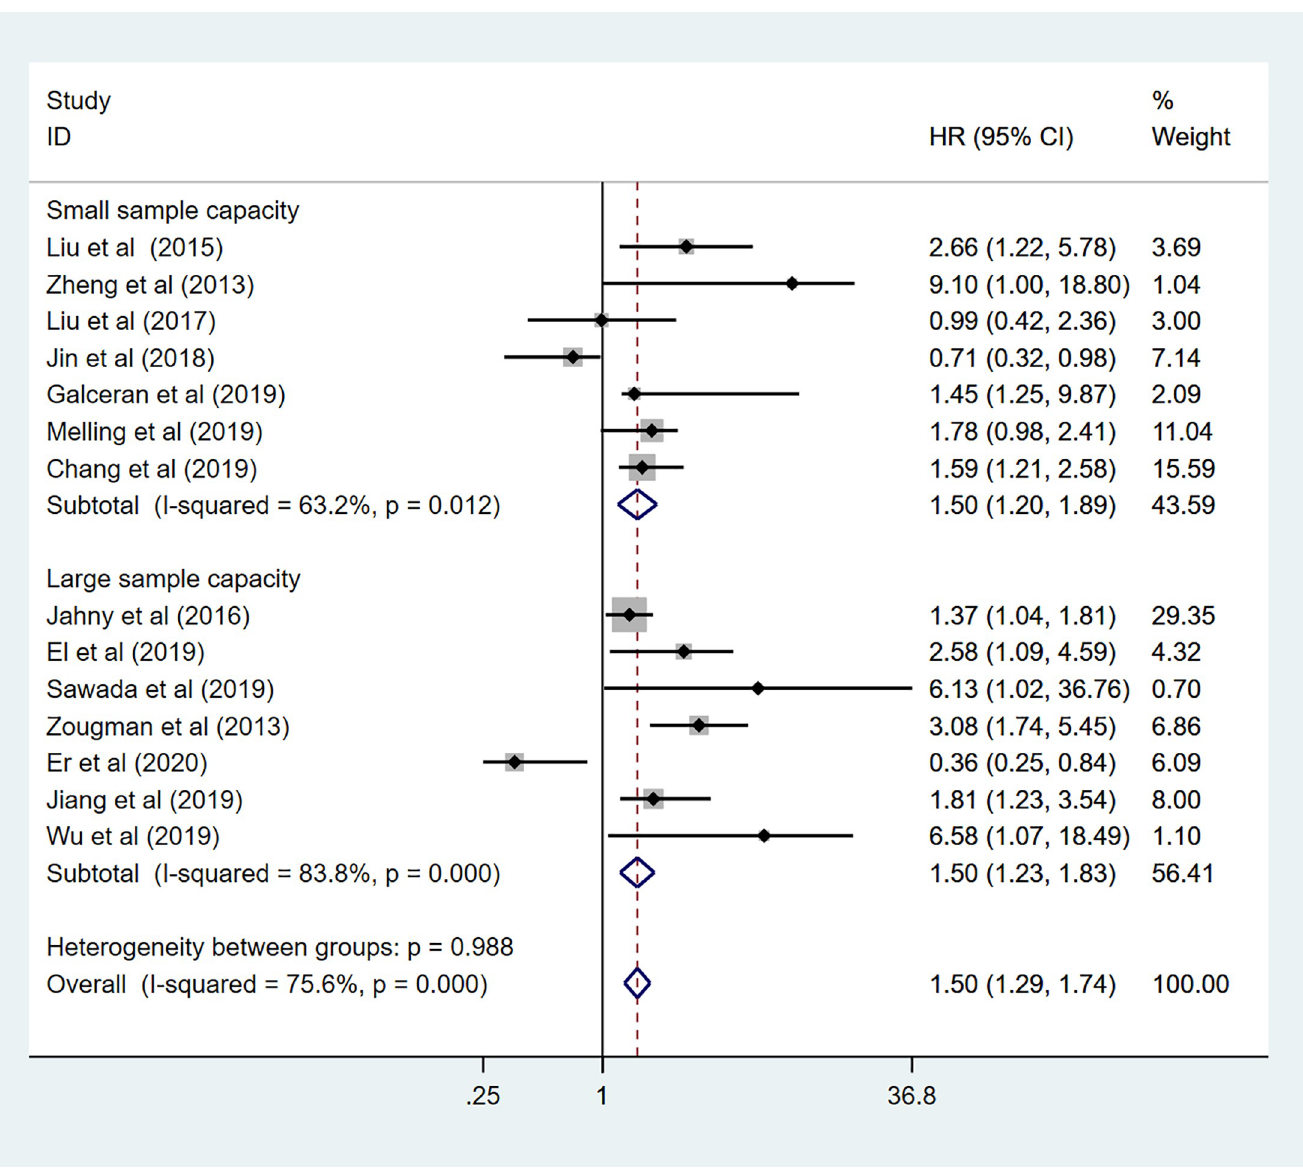
Fig 9. Forest plot for the subgroup analysis. Sample